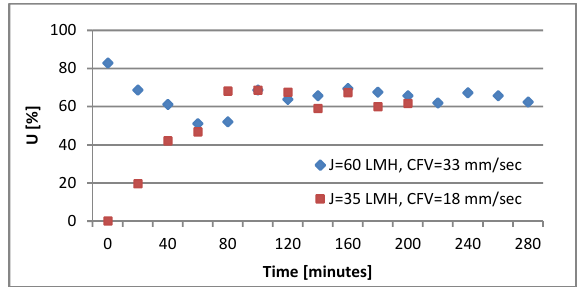
Fig. 12. Uniformity of fouling layer distribution a long hollow fiber membrane vs time at various CFV and permeate flux values (15 fiber length).